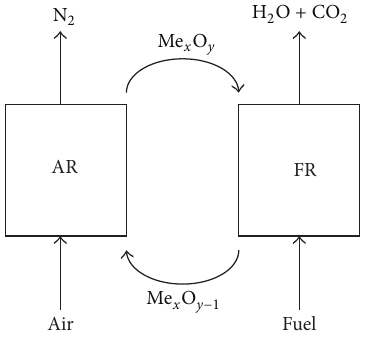
Figure 1: A schematic picture of the CLC